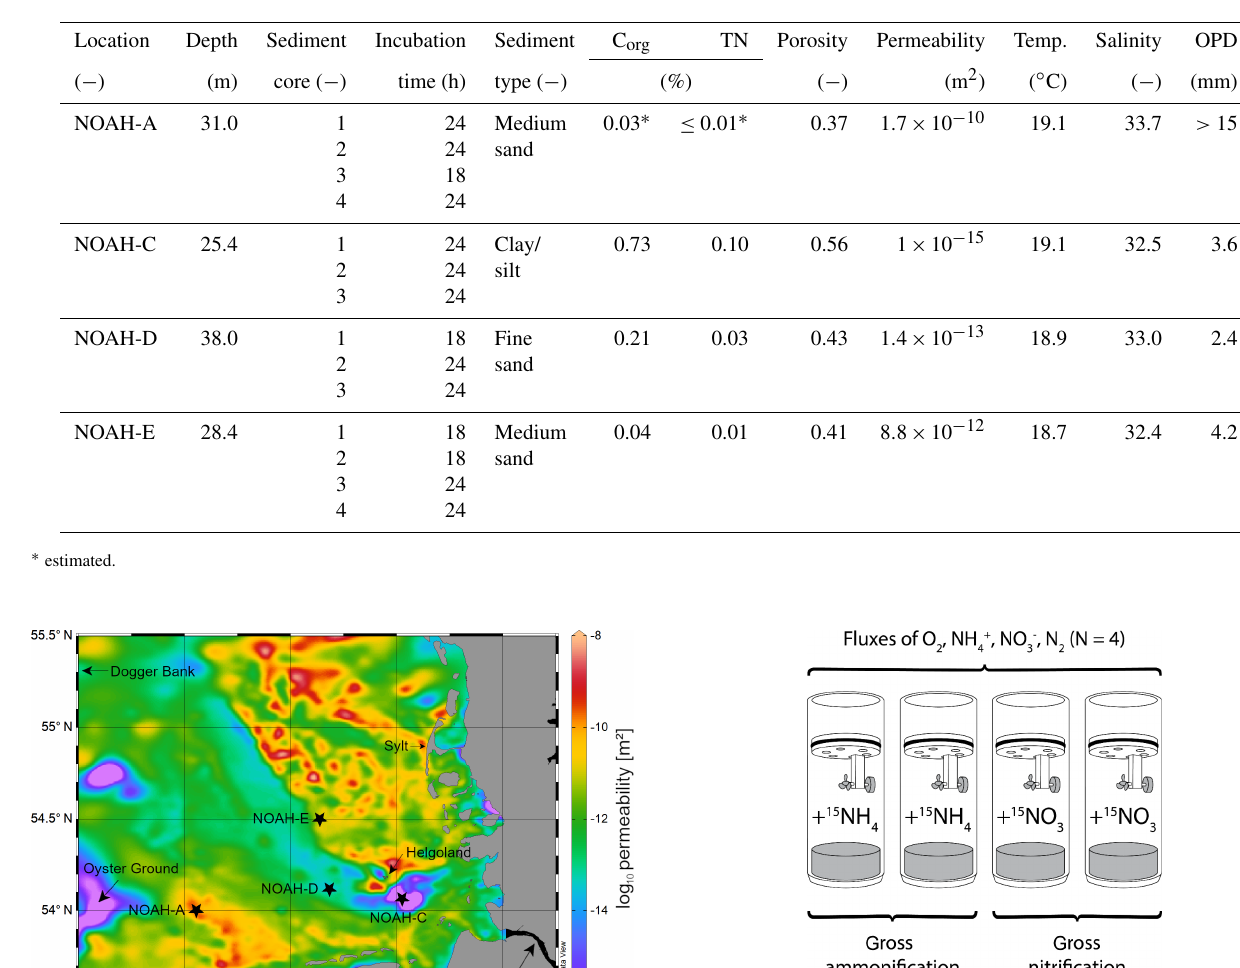
Table 2. Characteristics of bottom water and sediment characteristics of the sampled stations in the North Sea (https://doi.org/10.1594/ PANGAEA.846041, last access: 17 May 2020). C org means organic carbon content, TN means total nitrogen content of the surface sediment and OPD means oxygen penetration depth in the sediment.